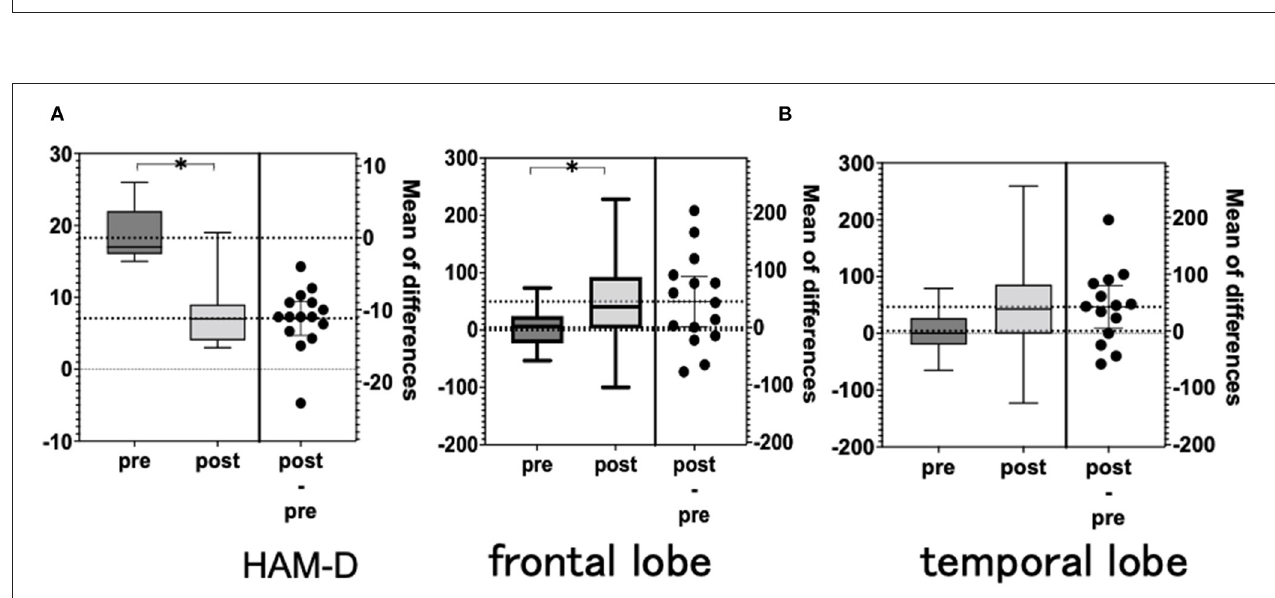
FIGURE 2 | (A) Schema of the integral value of blood flow (Area B) based on the means of 15 patients with depression after rTMS treatment. The integral value of oxygenated hemoglobin (red) represents an increase in blood flow for each probe. X-axis: time (sec), Y-axis: Hemoglobin signal (mM-mm) rTMS, repetitive transcranial magnetic stimulation. (B) Schema of the centroid value (timing of activation) based on the means of 15 patients with depression after rTMS treatment. The centroid value of oxygenated hemoglobin (red) is the timing of activation on each probe. X-axis: time (sec), Y-axis: Hemoglobin signal (mM-mm) rTMS, repetitive transcranial magnetic stimulation.